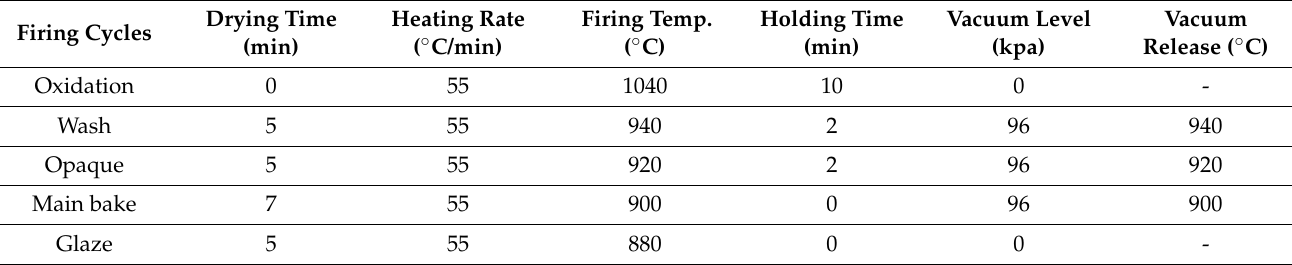
Figure 1. Experimental flow chart. FE-SEM: field emission scanning electron microscopy. HRXRD: Table 2. Multiple firing schedule for bonding porcelain.